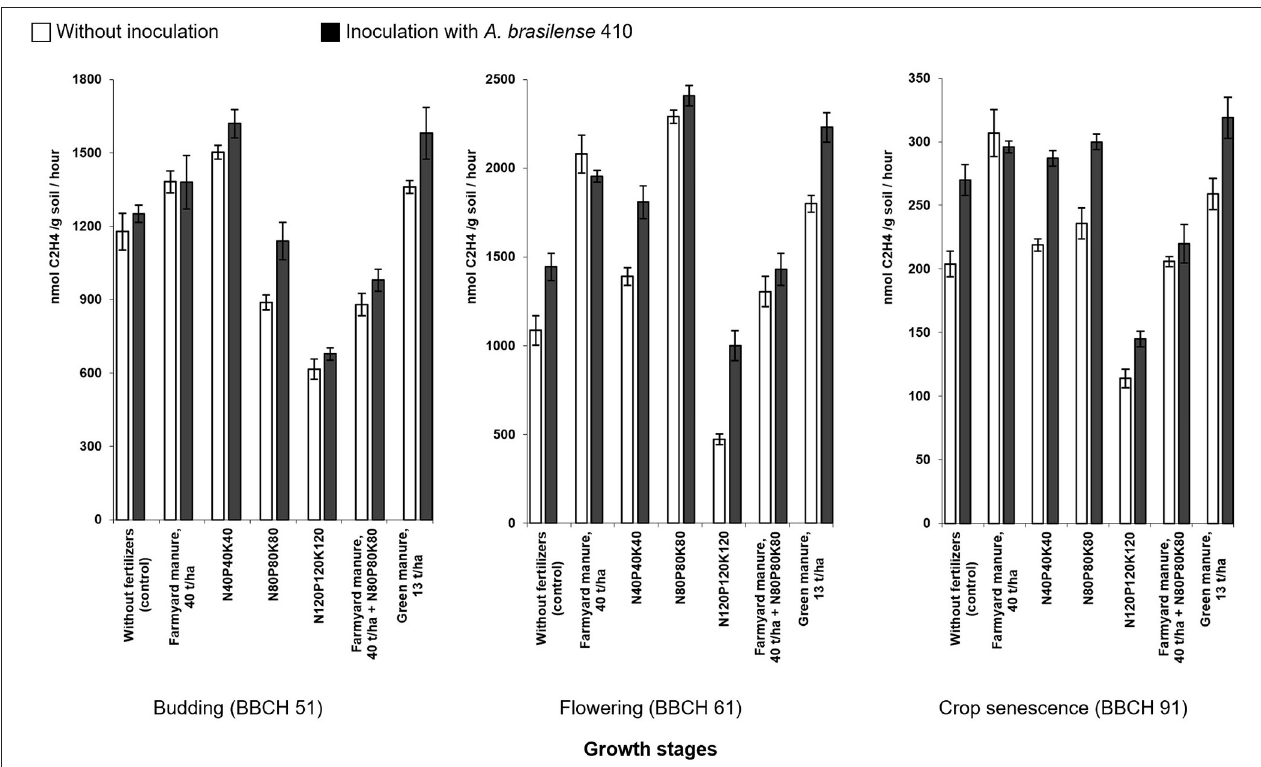
FIGURE 1 | The dynamics of the potential nitrogenase activity (ethylene production) in the rhizosphere soil of potato plants under the action of fertilizers and microbial inoculation with A. brasilense 410 (2018) (bars indicate standard deviation) .